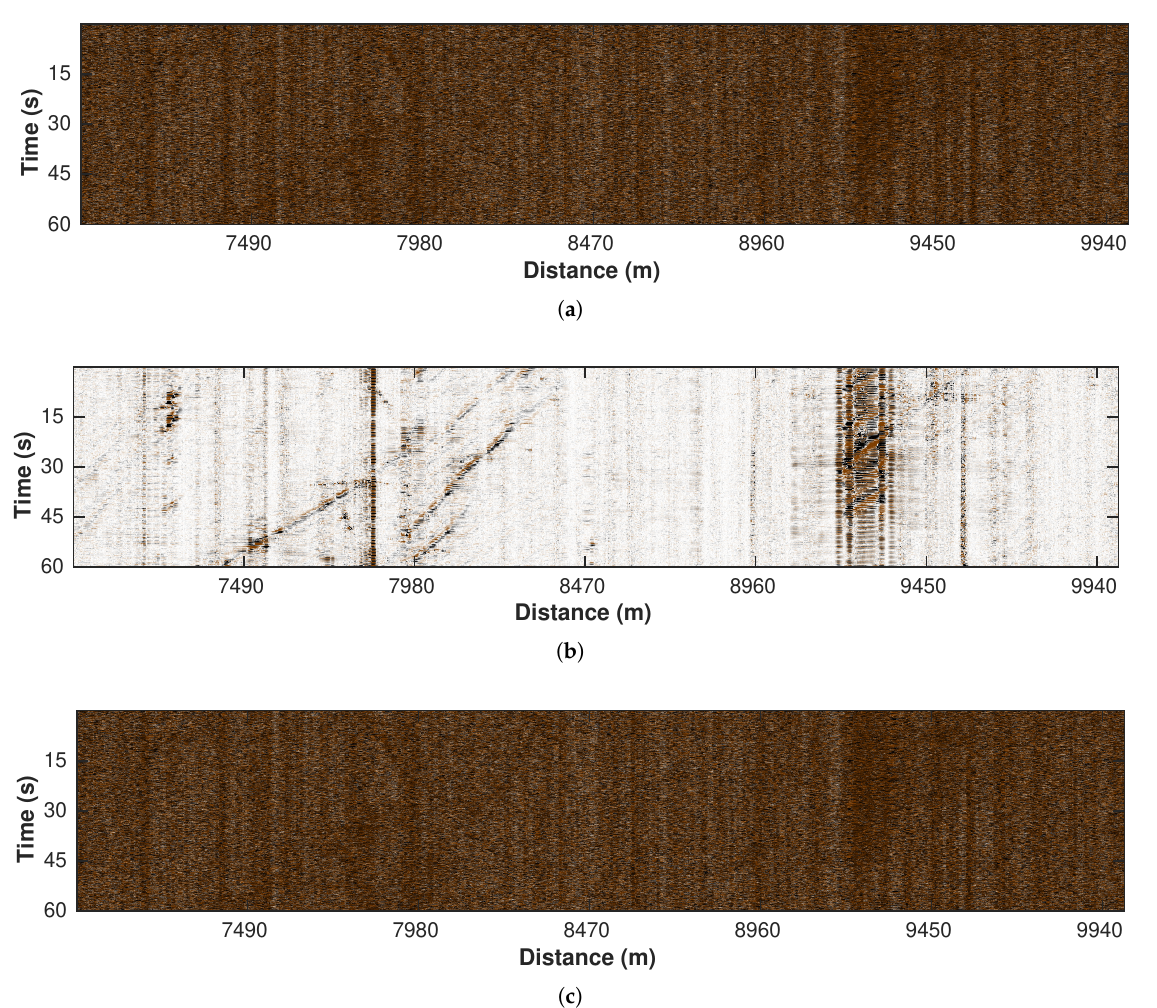
Figure 6. Processing results of low-pass filtering. ( a ) Original noisy data. ( b ) Low-pass filtered data. ( c ) Removed